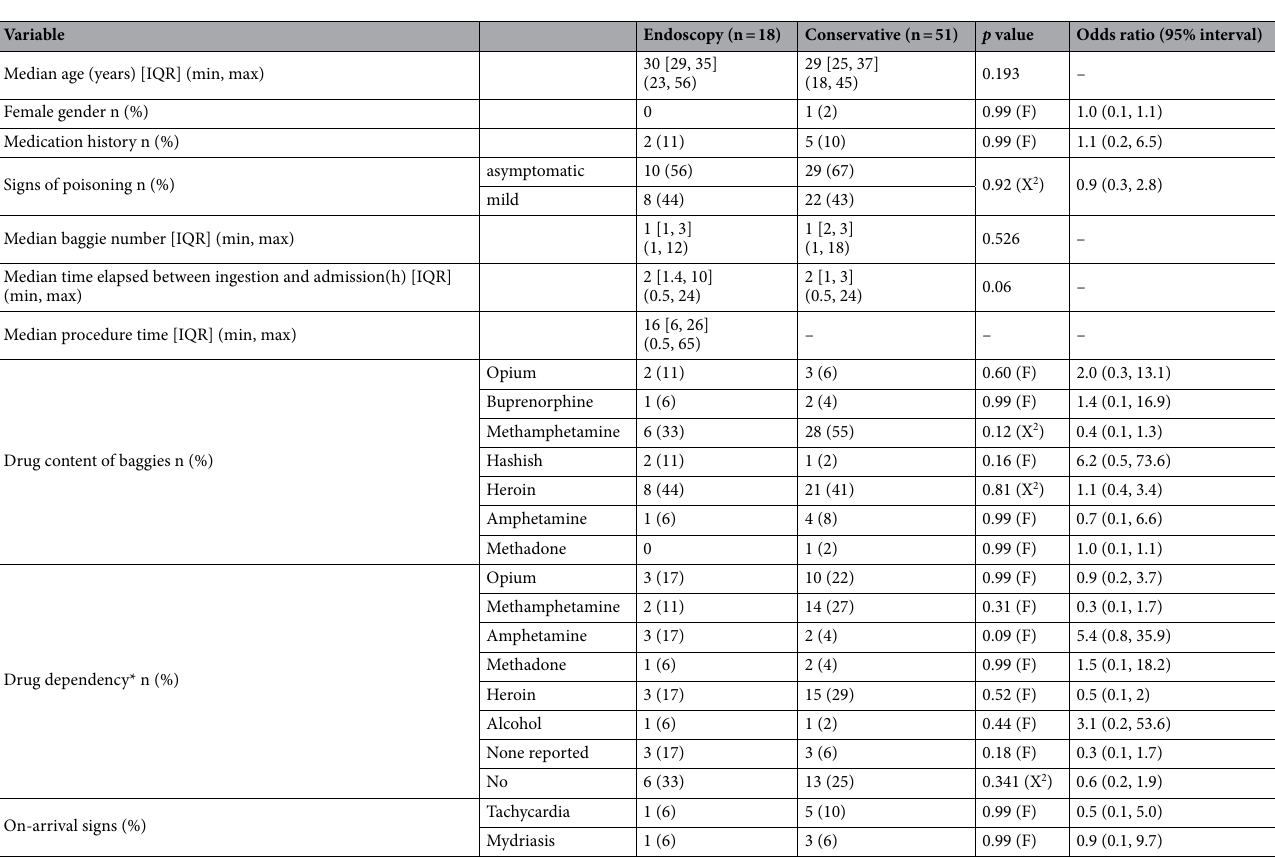
Table 1. Demographic characteristics of body stuffers (n = 69) and presentation on arrival. F = Fisher’s exact test, X 2 = Pearson Chi-Square. *Poly substance abuse in some